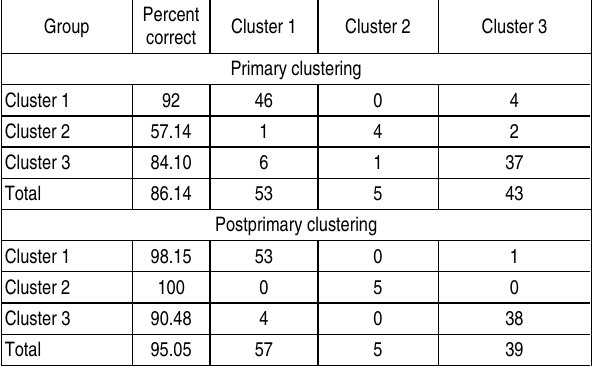
Table 2. The results of primary and postprimary